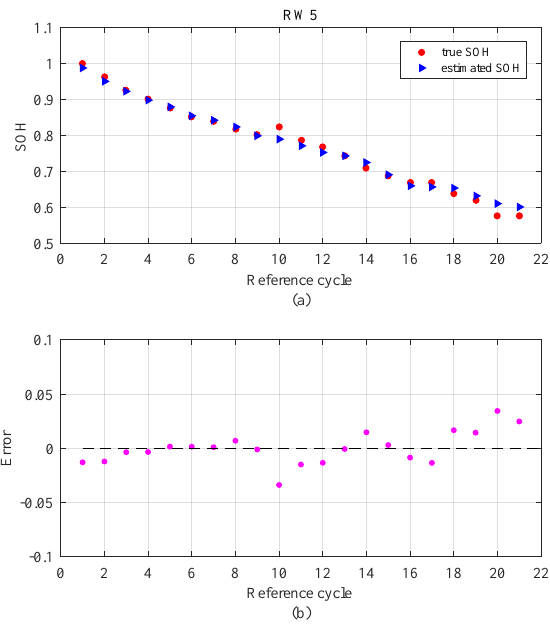
Figure 12. ( a ) The model fit of battery RW5, and ( b ) the error of the model